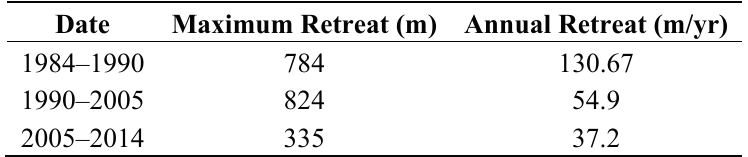
Table 6. Maximum retreat of the shoreline at Rosetta Nile branch promontory through 1984 to 2014 using combination of histogram threshold of Band 5 and Band ratio (B2/B5), (B2/B4).